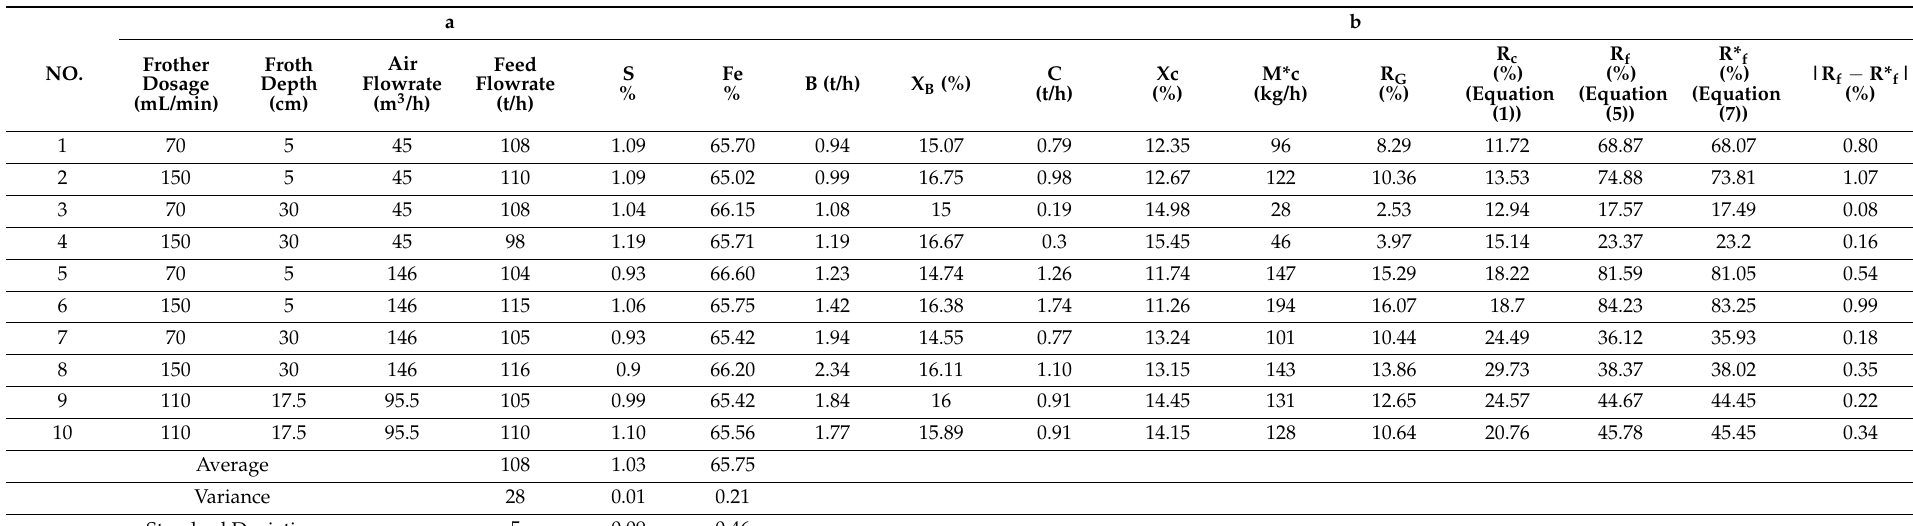
Table 1. The statistical factorial design data (a) and the froth recovery results